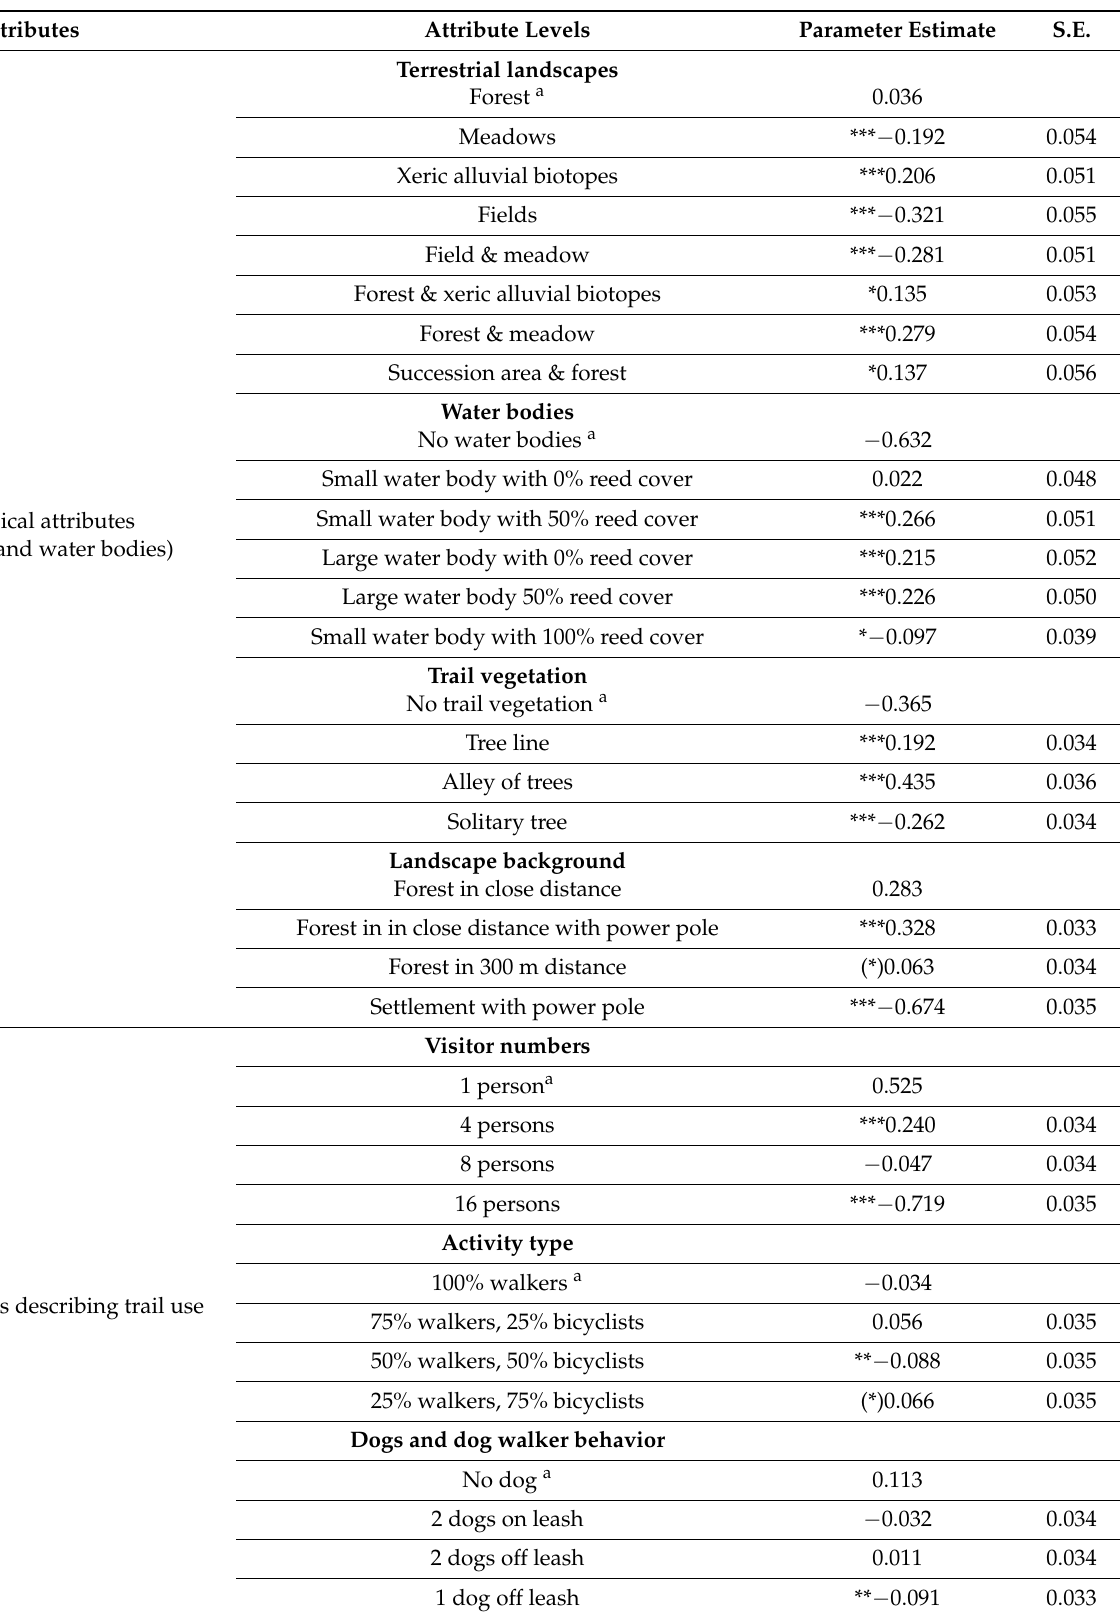
Table 3. Parameter estimates and standard errors for attribute levels of the DCE ( n =